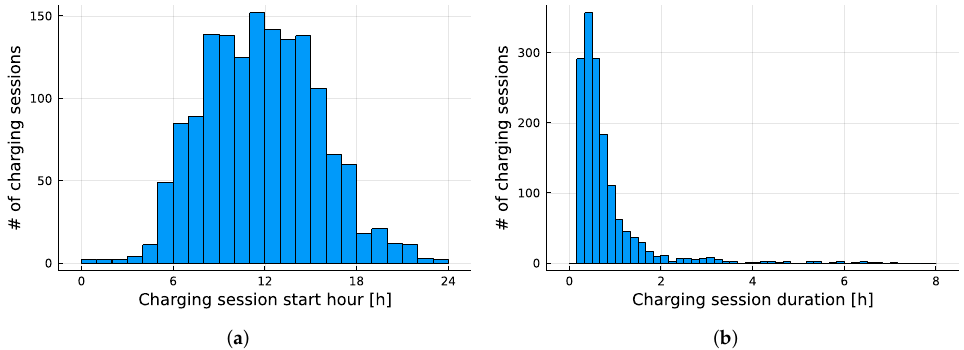
Figure 3. Histograms show the start of charging sessions ( a ) and duration ( b ) contained in the considered